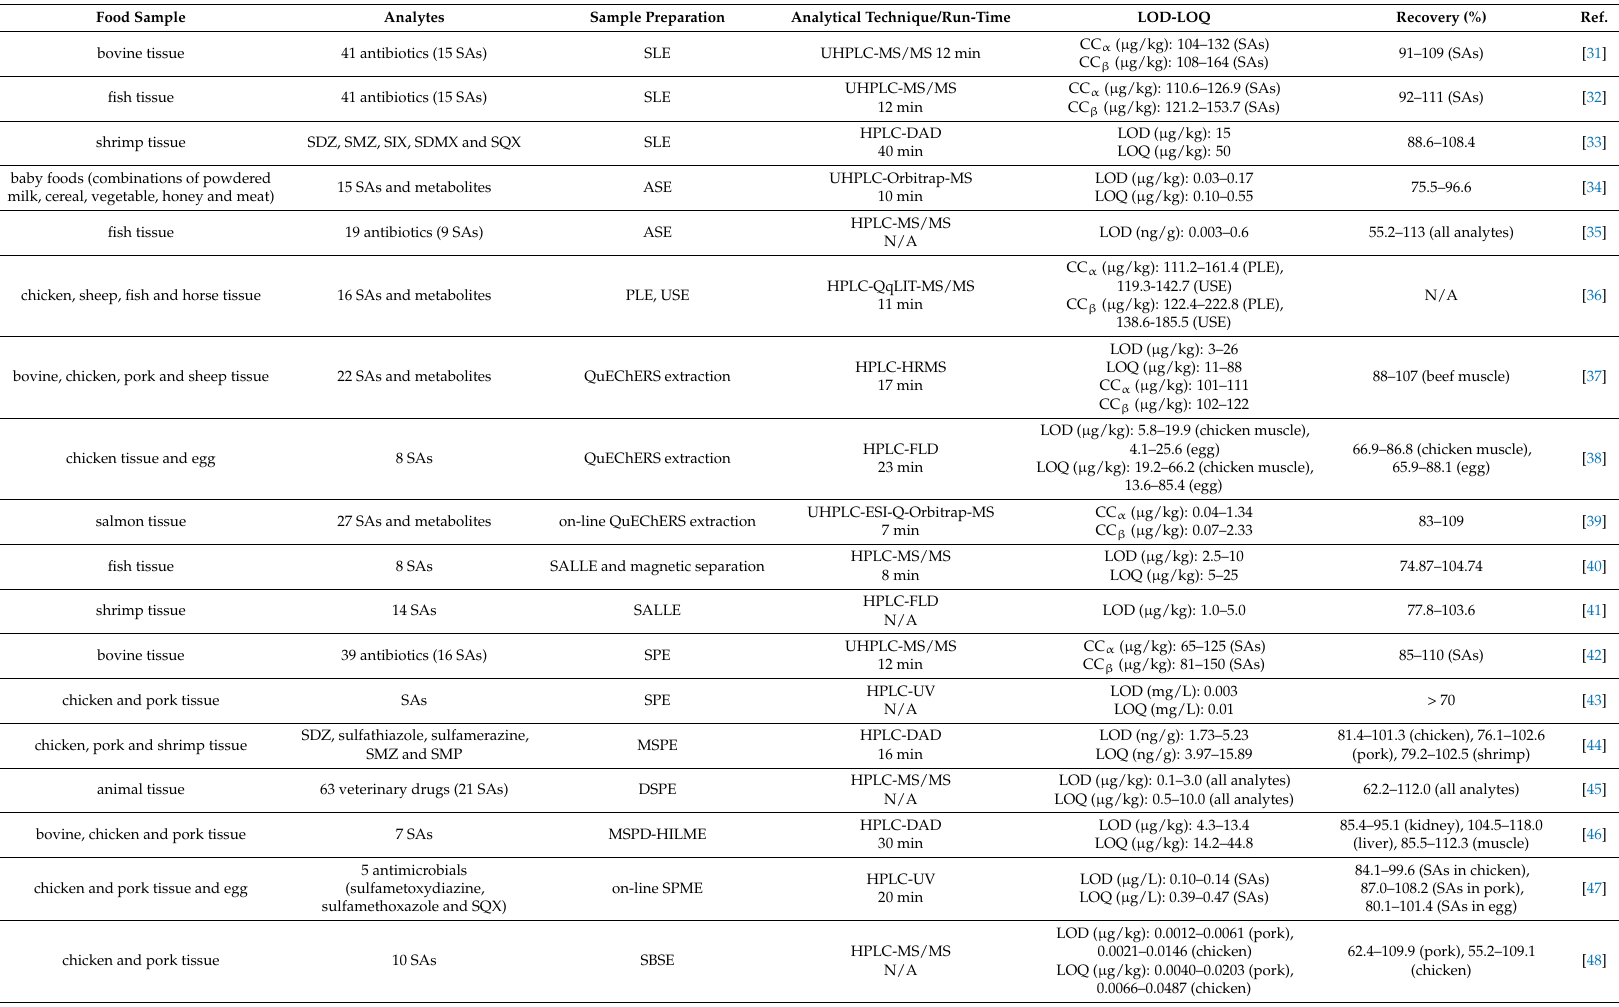
Table 2. Extraction of SAs from animal tissue